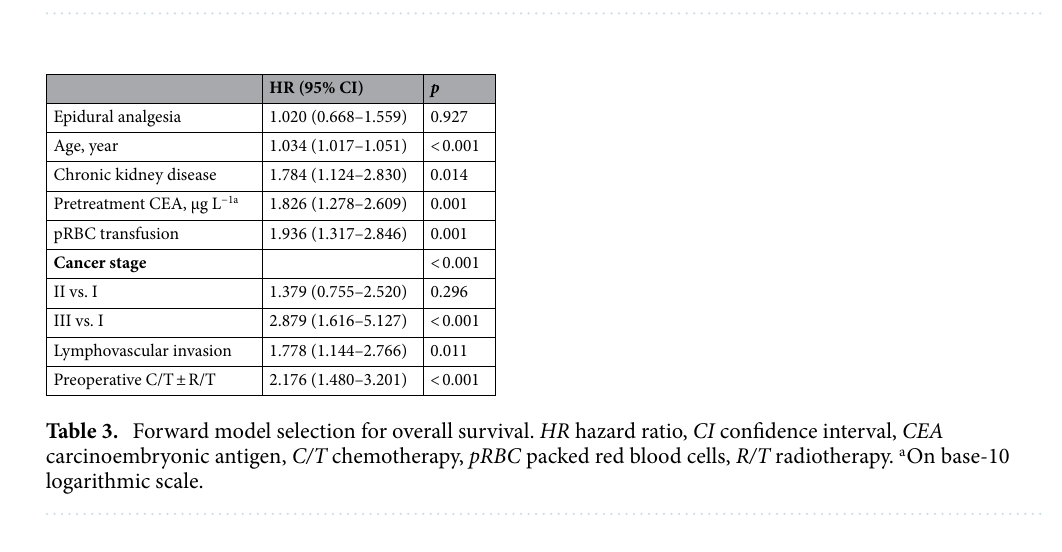
Table 2. Forward model selection for recurrence-free survival. HR hazard ratio, CI confidence interval, CEA carcinoembryonic antigen, C/T chemotherapy, R/T radiotherapy. a On base-10 logarithmic scale. b On base-2 logarithmic scale.